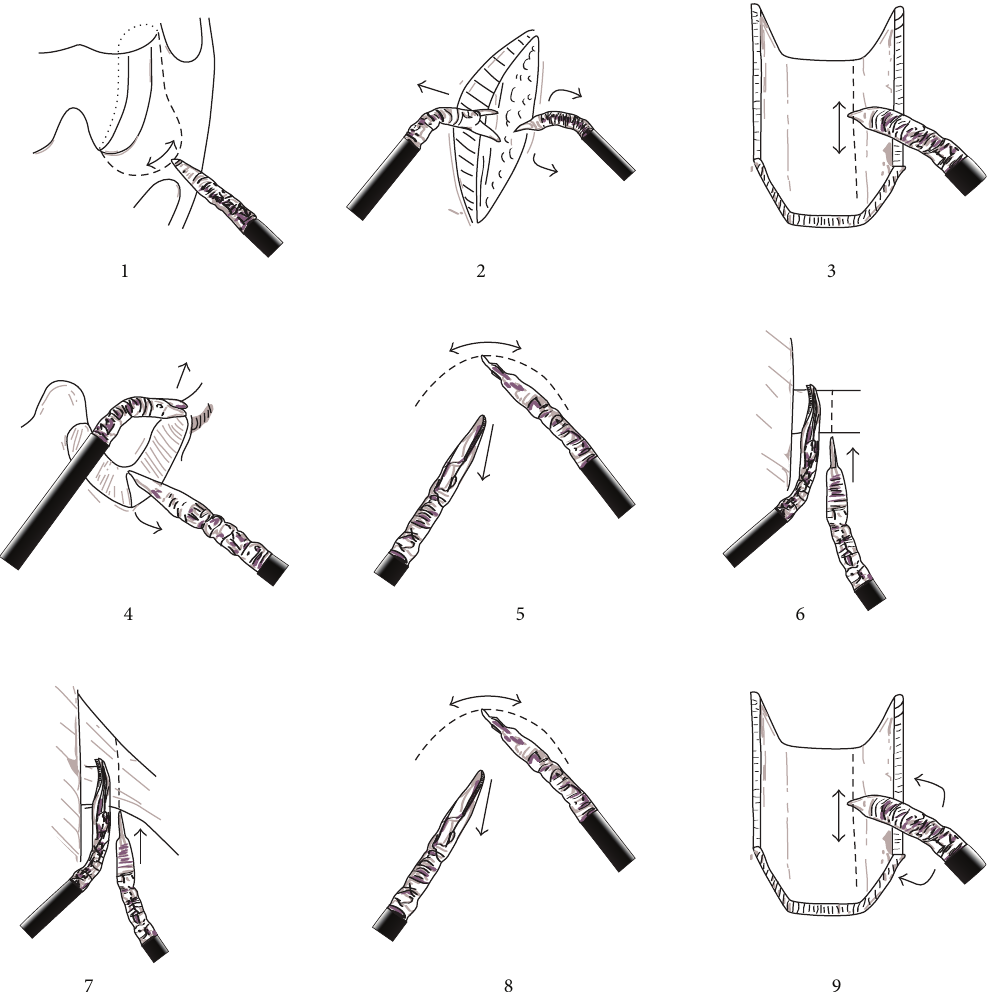
Figure 2: Schemes of the surgical steps for transoral robotic radical tonsillectomy. Step 1. Initial incision to mark the superior and lateral superficial limits (dashed line). The incision is made with the monopolar cautery in a question-mark fashion to extend into the pterygomandibular raphe. The dotted line shows the inferior and medial superficial limits that will be marked later. Step 2. Deep dissection starts after transecting the superior constrictor muscle. The parapharyngeal fat pad is reached and bluntly dissected laterally. Step 3. An index cut in the posterior pharyngeal mucosa marks the superficial medial limit. Step 4. The superior limit is completed with full width transection of the tonsillar pillars. Step 5. Inferior superficial limit in the tongue base. Steps 6 and 7. Completion of the lateral limit by transection of the styloglossus (6) and stylopharyngeus muscles and the rest of connective tissue attachments (7). Step 8. Completion of the inferior limit (deep tongue base). Step 9. Completion of the deep medial limit (superior constrictor muscle) approaching either medially, laterally, superiorly, or inferiorly depending on the